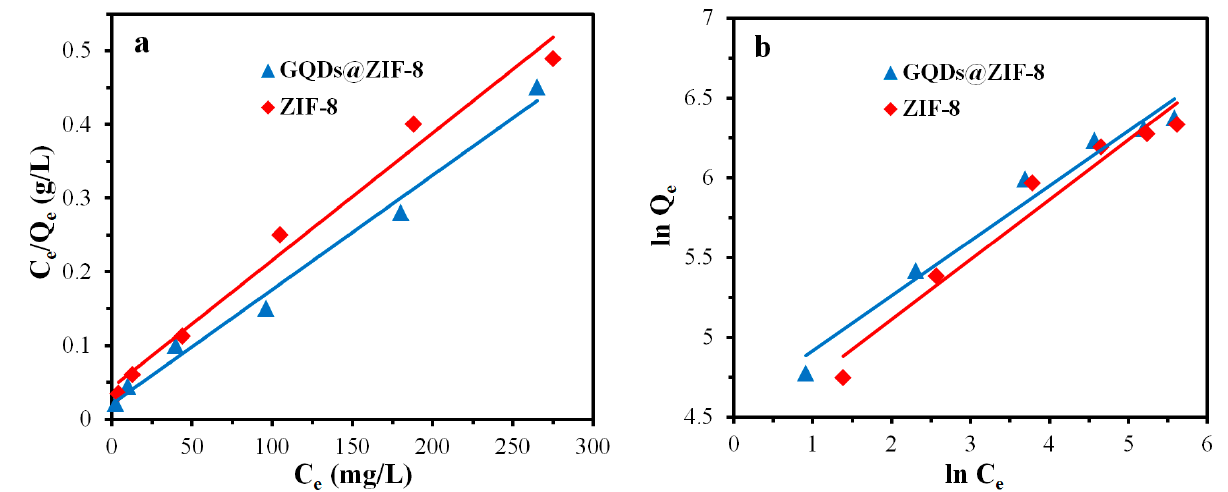
Figure 15. Langmuir model ( a ), Freundlich model ( b ) fitting curves of ZIF-8 and GQDs@ZIF-8 for toluene adsorption.